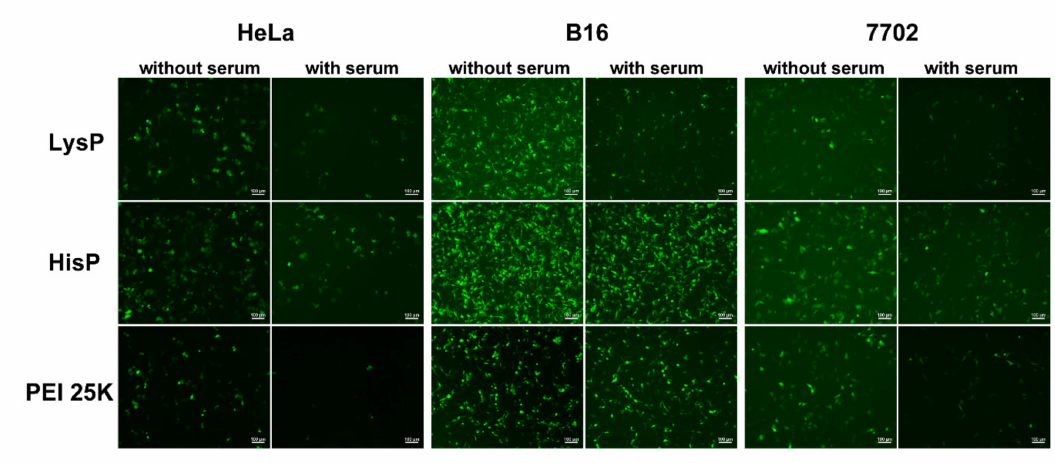
Figure 6. Fluorescence microscope image of pEGFP-transfected cells in the at their optimal weight ratios. PEI 25 kDa ( w / w = 1.4) was used as